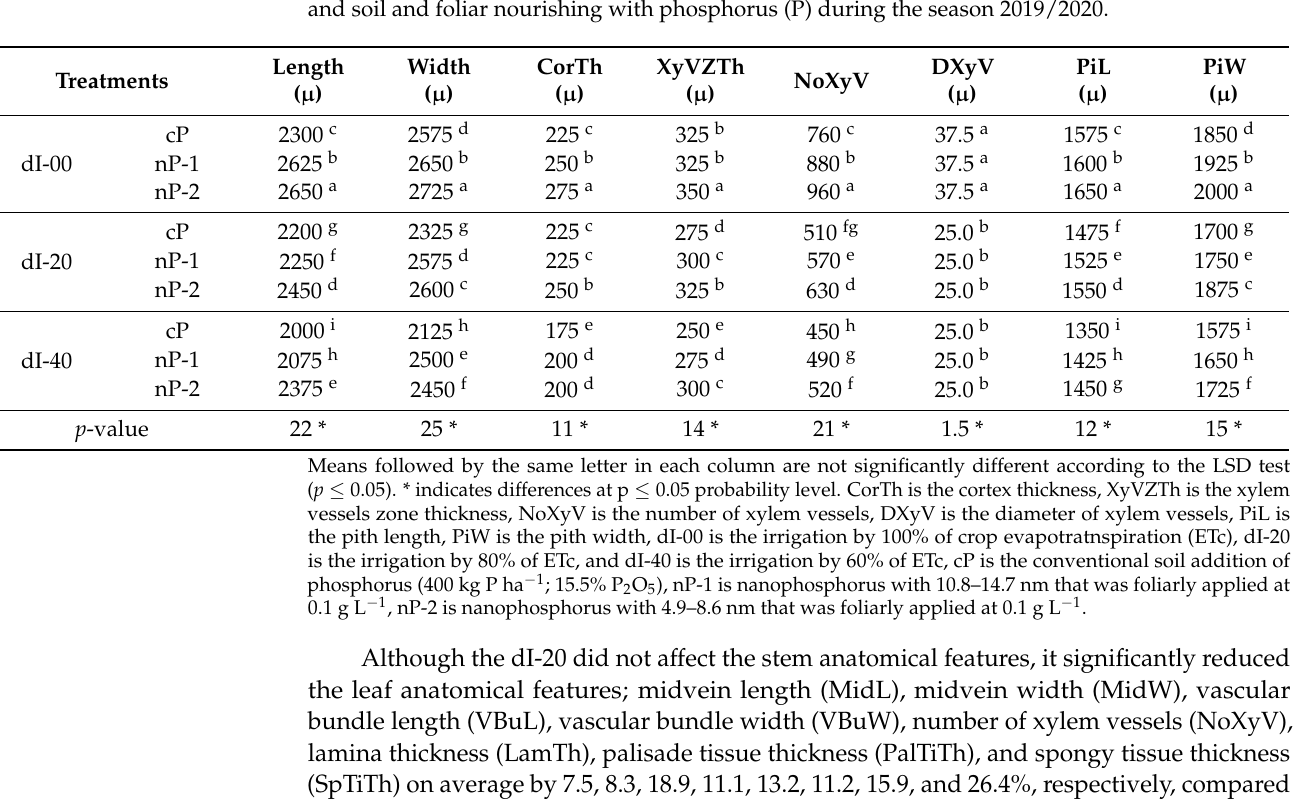
Table 9. Stem anatomical features of fenugreek plants as affected by different irrigation water regimes and soil and foliar nourishing with phosphorus (P) during the season